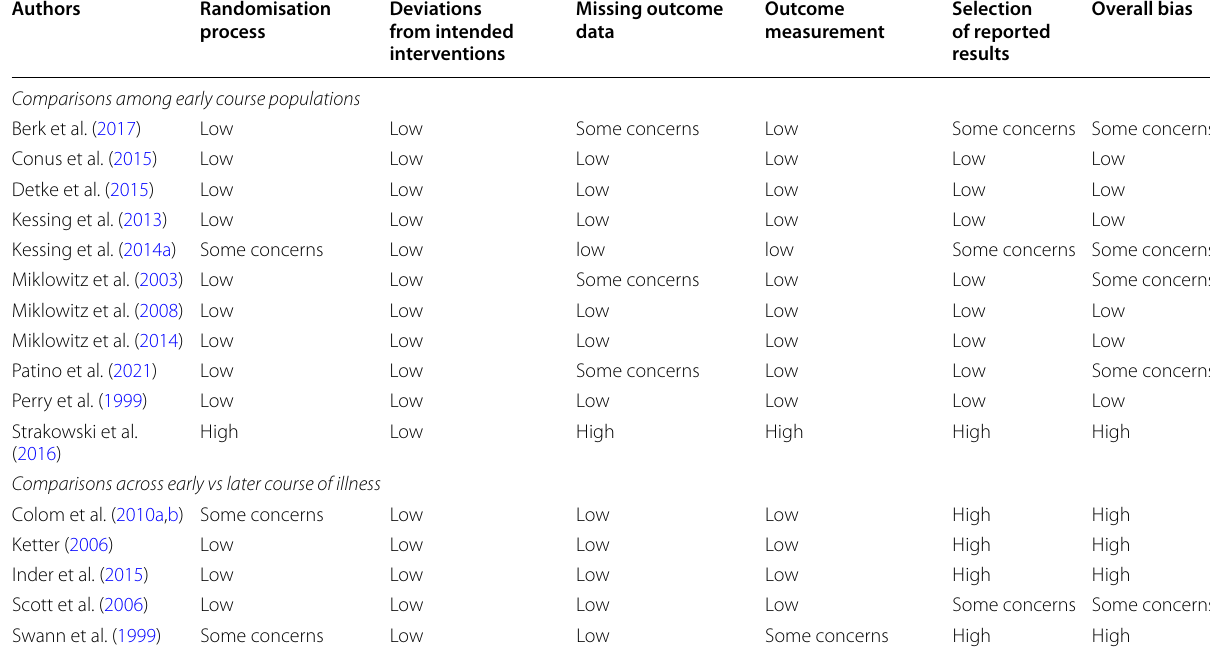
Table 2 Risk of bias from included randomised controlled